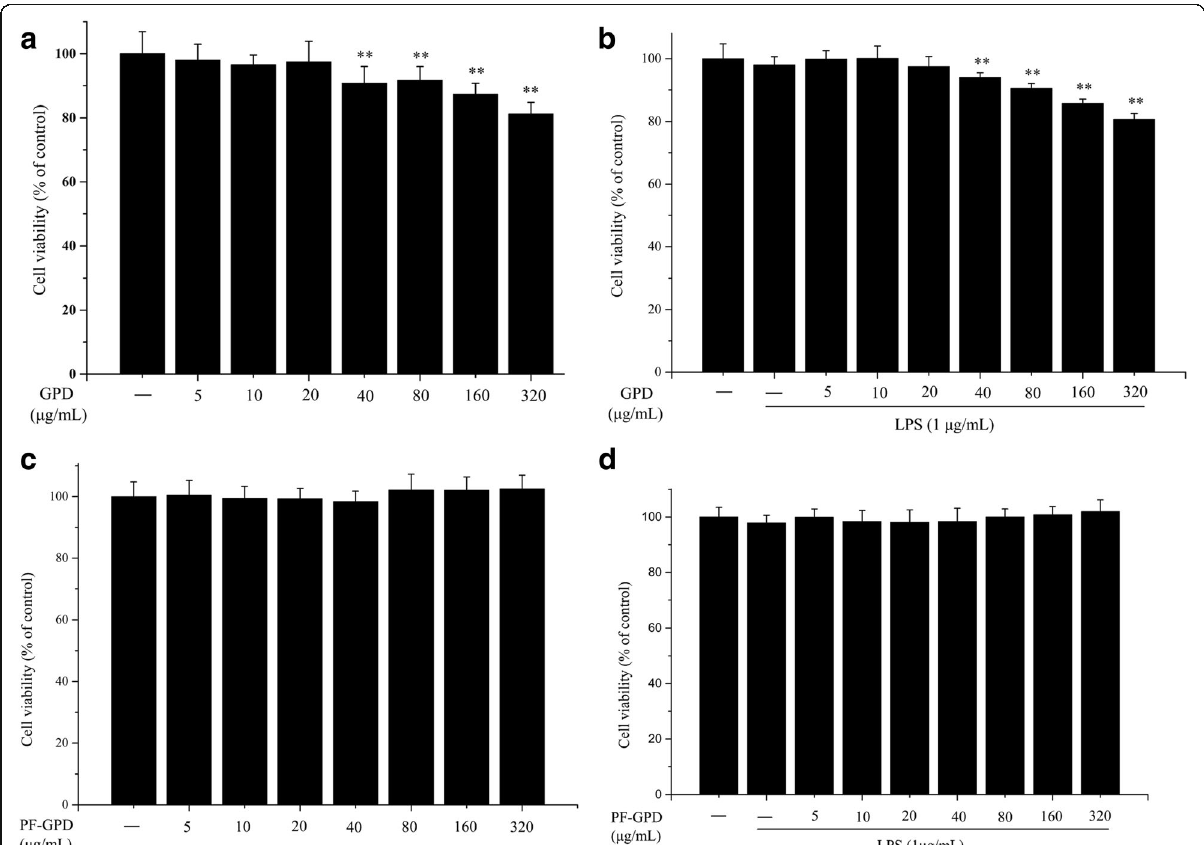
Fig. 2 Effect of GPD and PF-GPD on the LPS-induced NO production in RAW 264.7 cells. Cells treated with indicated concentrations of GPD or PF-GPD were stimulated without or with 1 μ g/mL of LPS for 24 h. The dexamethasone (DEX, 0.5 μ g/mL) in 50 μ L PBS were performed into positive control. The treated cell culture media were used to measure the amount of nitrite to evaluate NO production. ## P < 0.01 compared with untreated group; * P < 0.05, ** P < 0.01 compared with the LPS